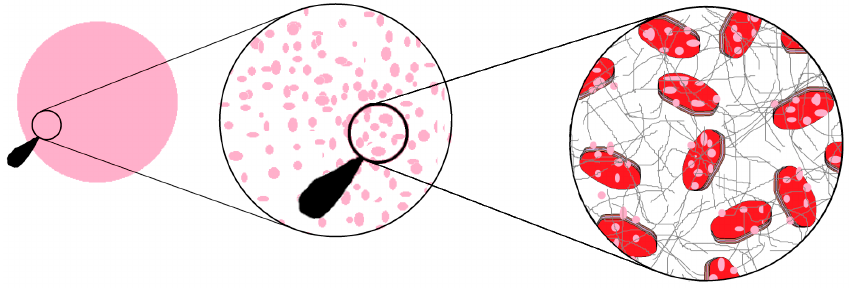
Figure 8. Possible structural organization of a pH-responsive silk patch. Represented are the silk proteins, the Laponite platelets and on the Laponite platelets the dye molecules.